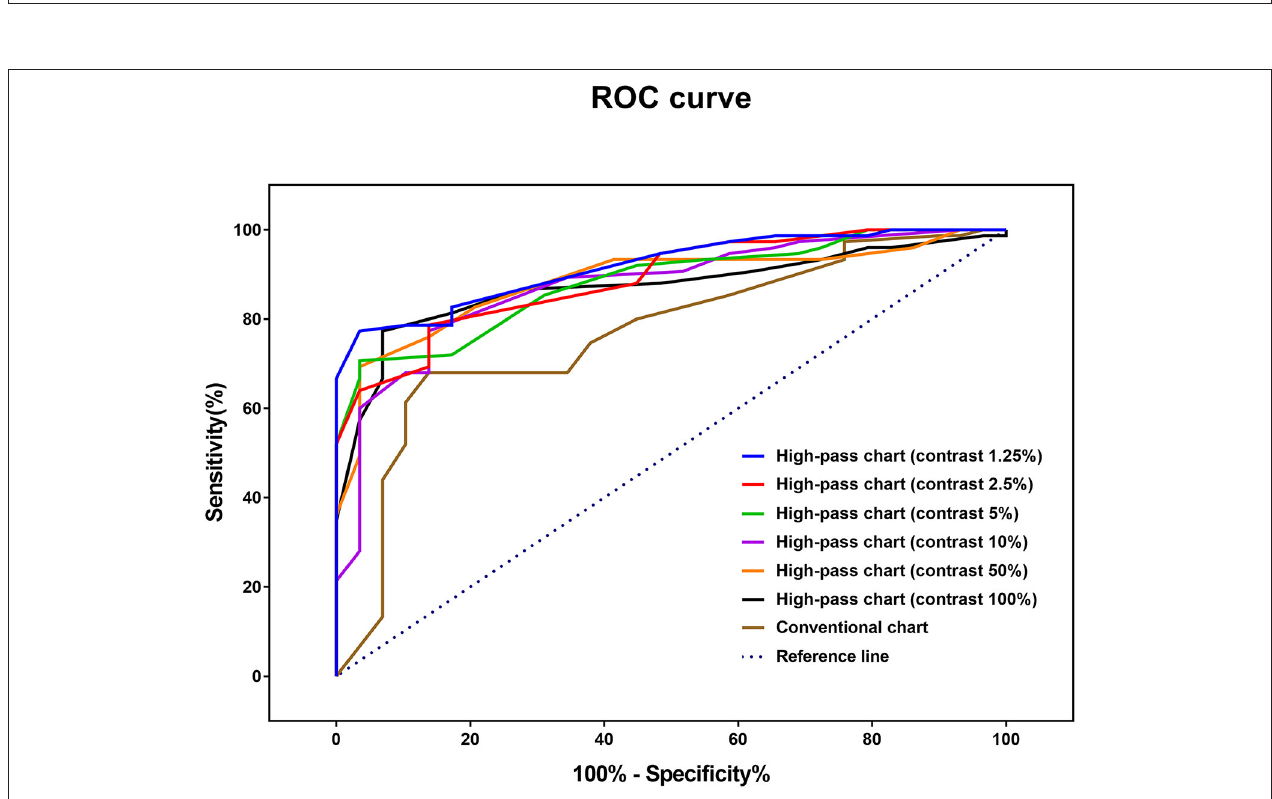
FIGURE 6 | Receiver operating characteristic (ROC) curve for each VA test to detect glaucoma damage.